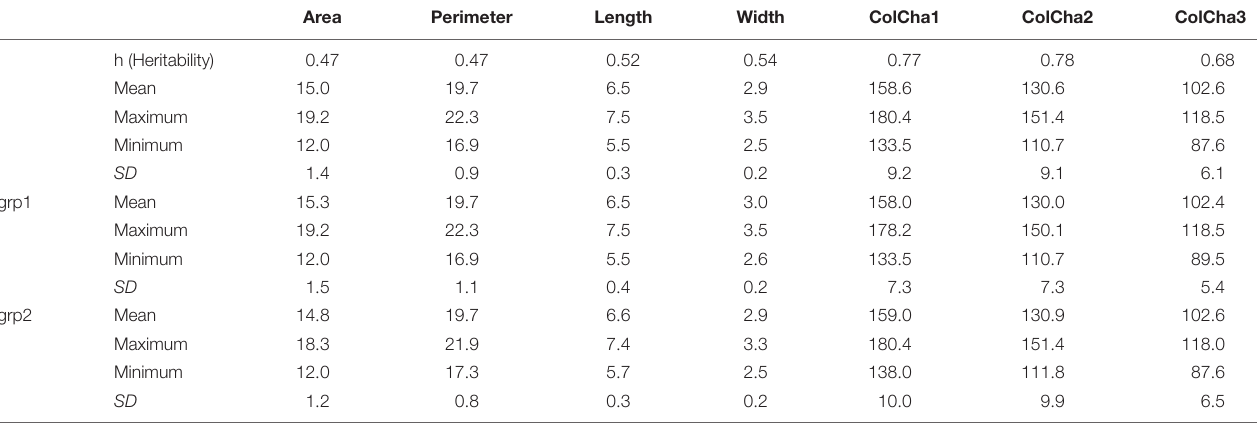
TABLE 1 | Summary statistics and genomic heritability for grain characteristics for the entire set collection and per subpopulation when K = 2 (grp1 and grp2) of the bread wheat